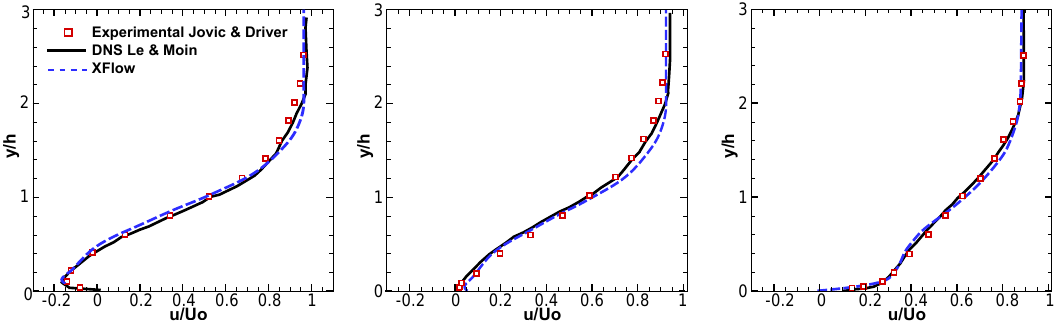
Figure 6. Mean x-velocity profiles for numerical and experimetal results at different longitudinal sections: X / h = 4 ( left ), 6 ( middle ) and 10 ( right ).